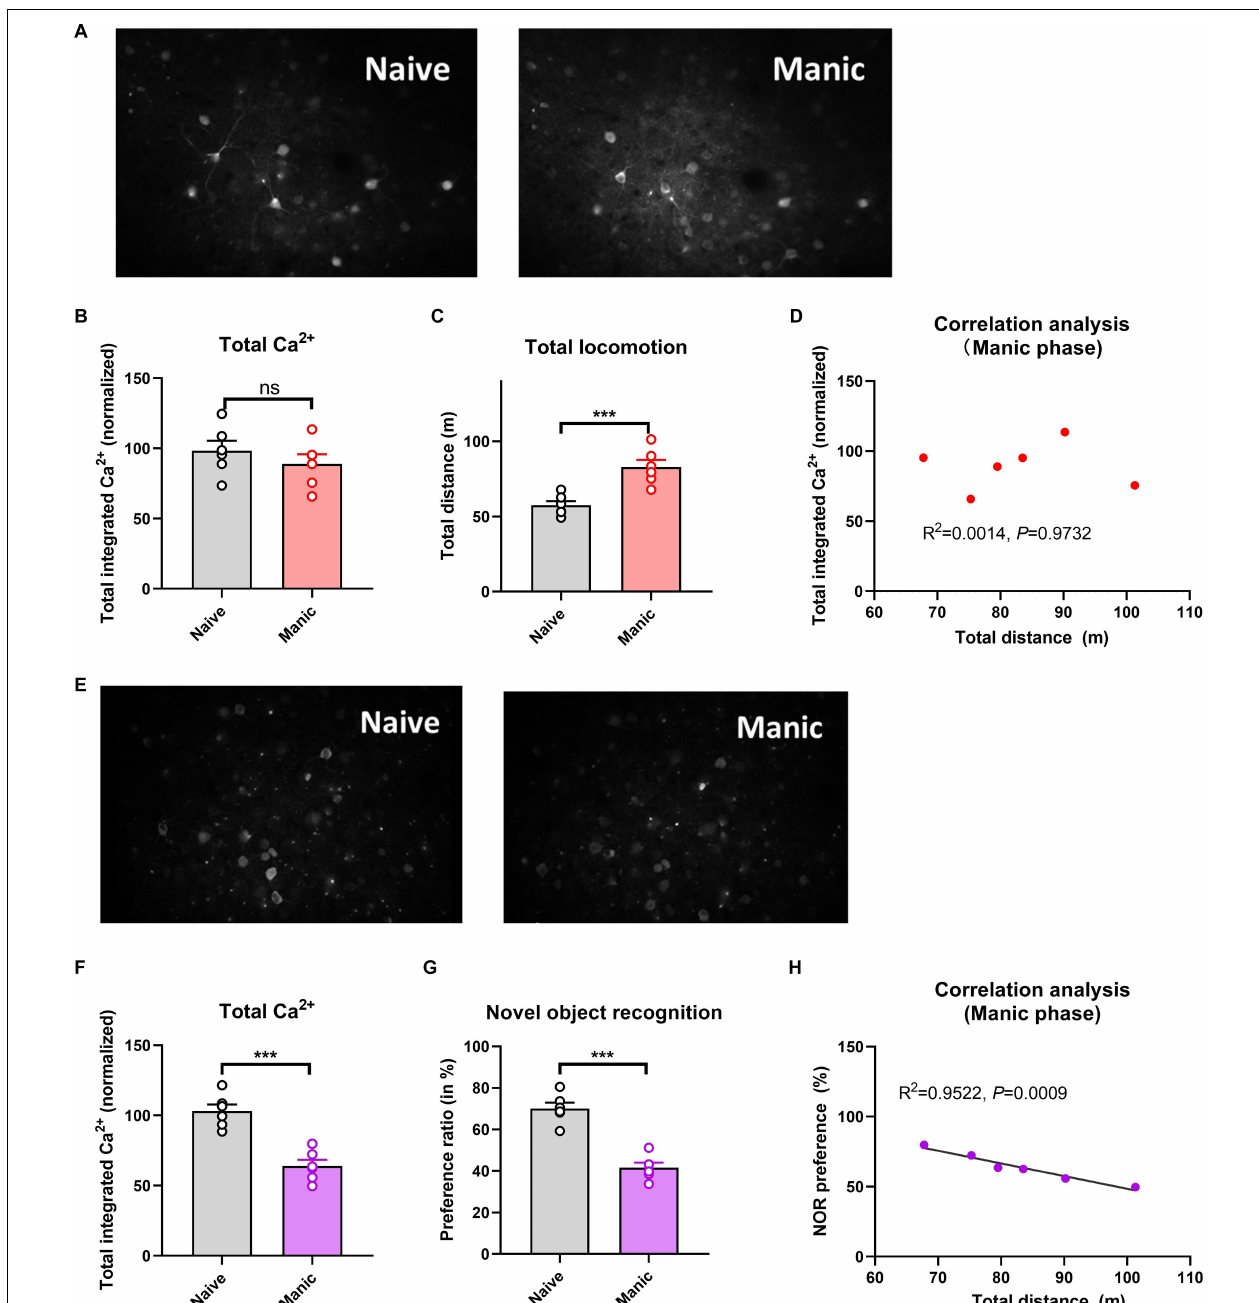
FIGURE 2 | Brain Ca 2+ activity and behavioral index alterations in mice with BPD exposed to ketamine and controls. Note : Compared with the naïve group (six mice, group-housed), mice in the manic phase ( n = 6, group-housed) showed similar normalized integrated Ca 2+ activity (96.89 ± 13.00 vs. 92.18 ± 10.44, A,B ) but significantly more total locomotion (53.11 ± 9.25 vs. 79.66 ± 7.77 m, C ); mice in the manic phase also showed Ca 2+ hypoactivity in the prefrontal cortex (E,F) , and had poorer novel object recognition preference ratios (G) . The preference ratio, but not the normalized integrated Ca 2+ activity, correlated with the total